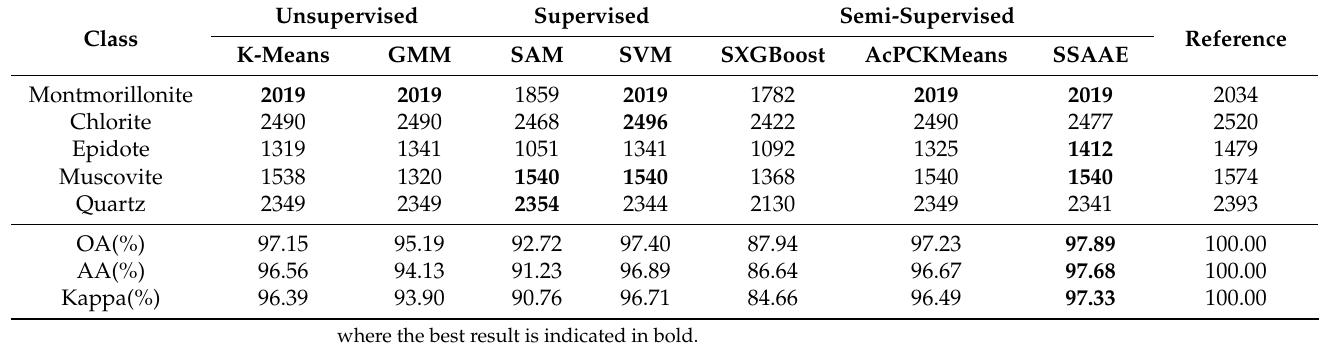
Table 3. Comparison of classification results using different methods on the synthetic dataset.